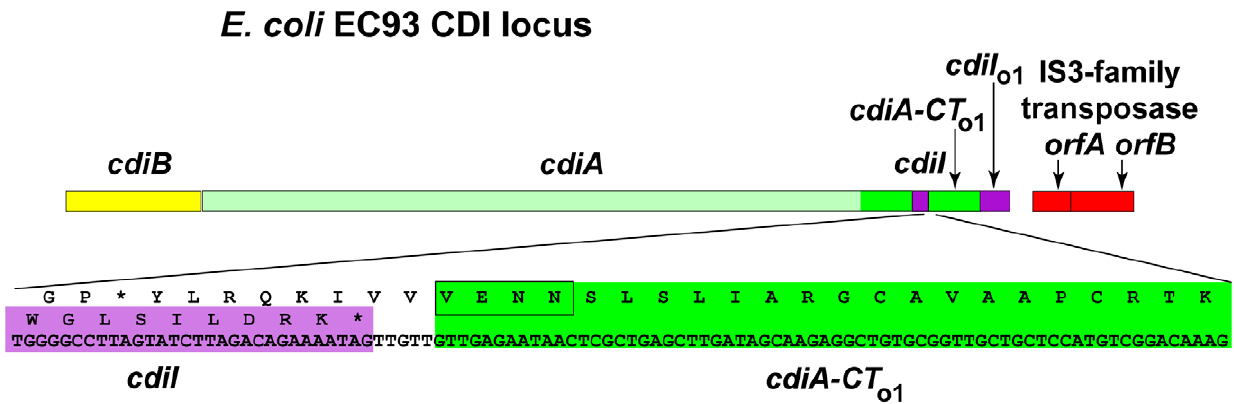
Figure 1. E.coli EC93 contains an orphan cdiA-CT/cdiI module. The CDI region of E. coli EC93 is depicted, with cdiB , cdiA and cdiI genes shown in yellow, green and purple, respectively. The cdiA coding region upstream of the encoded VENN motif is shown in light green, and the cdiA-CT sequence is shown in dark green. The orphan cdiA-CT fragment ( cdiA-CT o1 ) and orphan cdiI ( cdiI o1 ) are dark green and purple, respectively. The nucleotide sequence of the cdiI - cdiA-CT o1 junction and the predicted reading frames are shown in detail. Sequences similar to transposable element genes are shown in red. doi:10.1371/journal.pgen.1002217.g001 CT encoded by the adjacent cdiA PB1(II) gene (39% identity over 179 residues), and also to CdiA-CTs from Klebsiella pneumoniae 342 (B5Y0C2; 61% identity over 263 residues) and Dickeya dadantii Ech586 (D2BZ75; 59% identity over 263 residues).